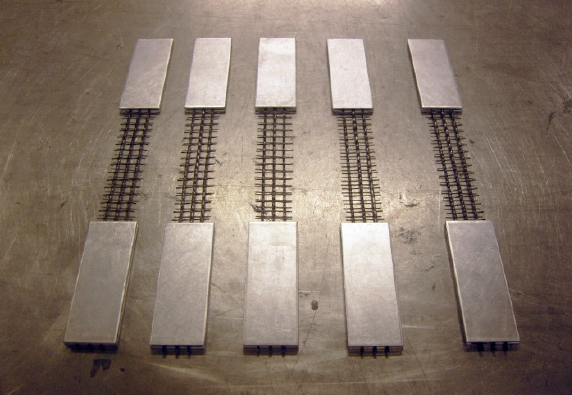
Figure 3. Basalt samples equipped with aluminium tabs.